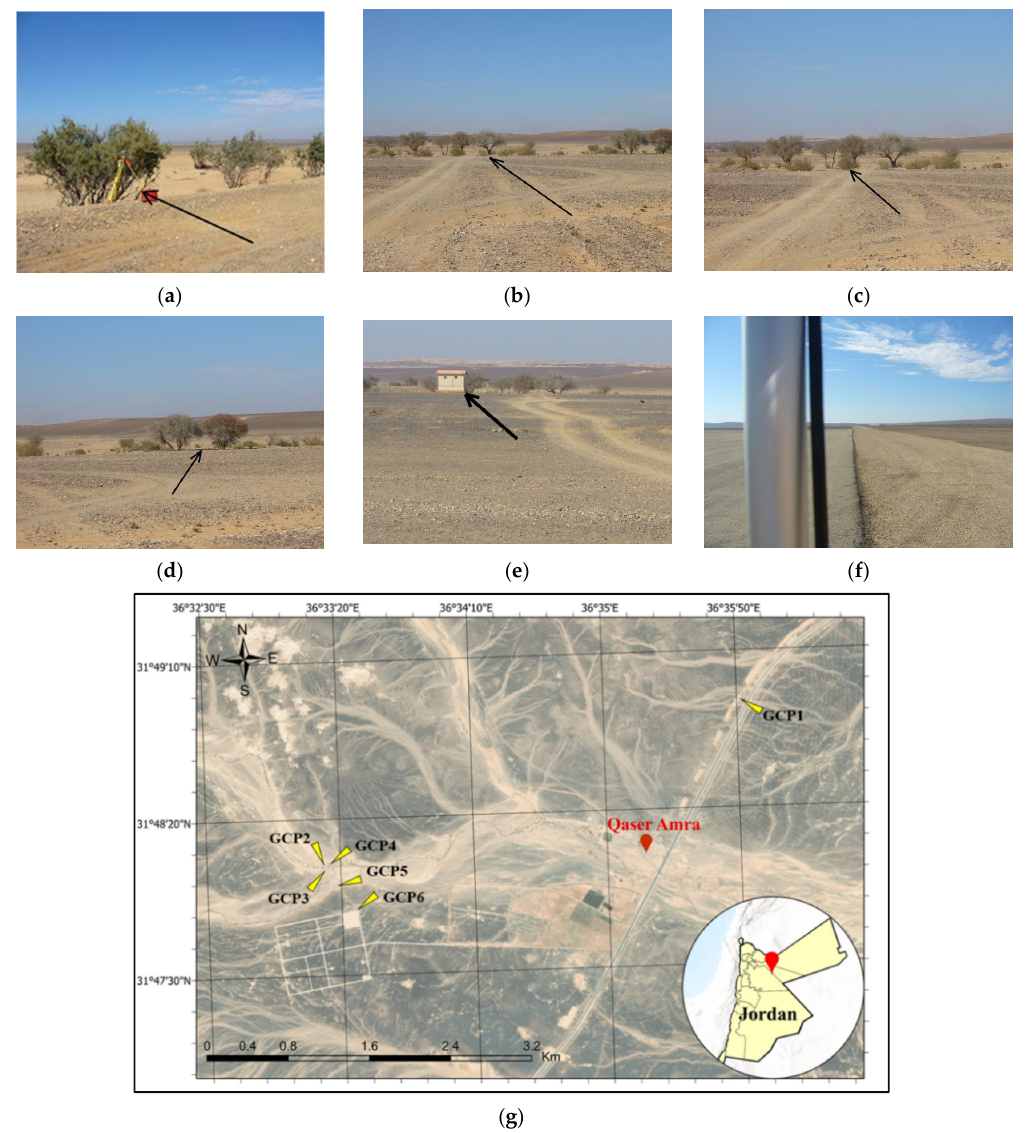
Figure 7. Location of the GCPs at Qaser Amra: ( a ) GCP1; ( b ) GCP2; ( c ) GCP3; ( d ) GCP4; ( e ) GCP5; ( f ) GCP6; ( g ) Aerial View for GCP Locations.